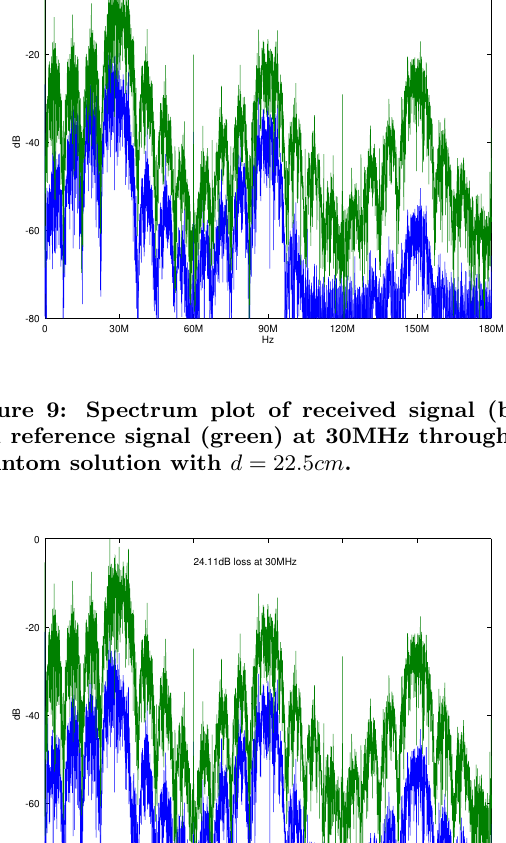
Figure 8: Channel attenuation in phantom solution and in air for d = 11 . 25 cm and d = 22 . 5 cm .